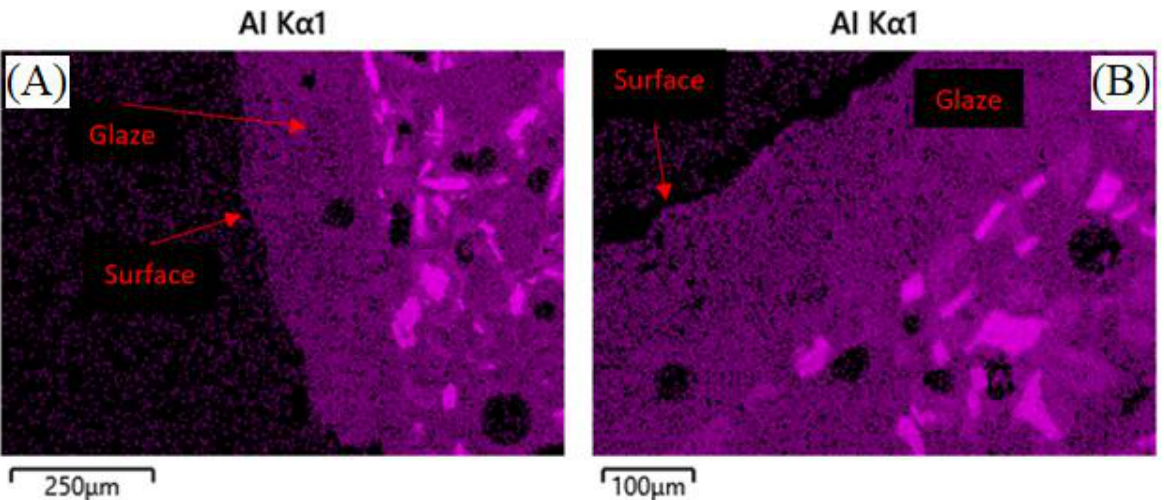
Figure 7. Surfaces of ASH-G composite after heating to 775 ◦ C for 240 h without ( A ) and with ( B ) KCl. A reduced glaze is present in both